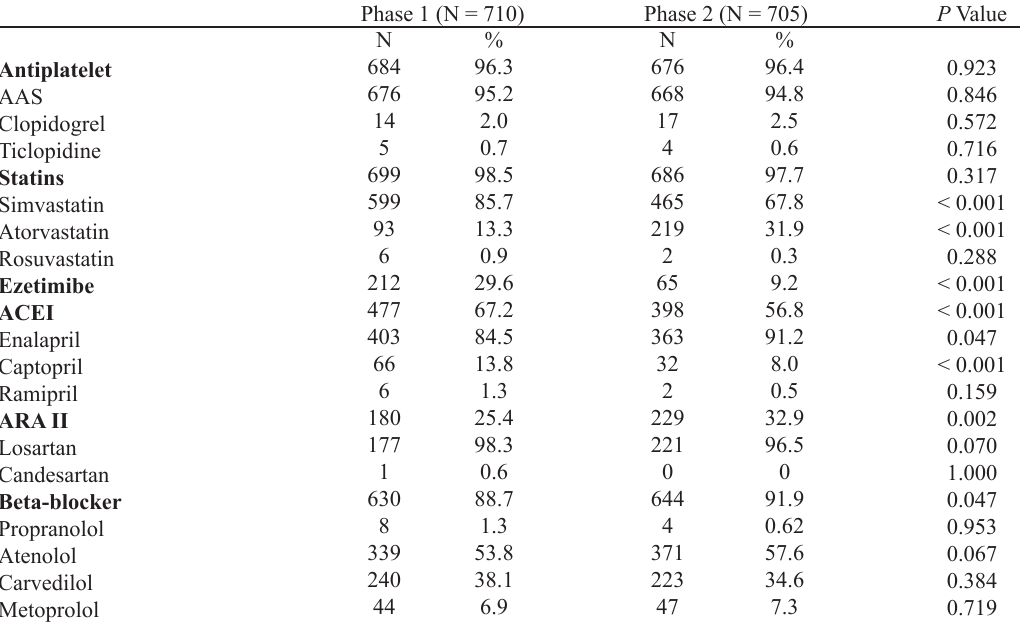
Table 5. Recommended medications.